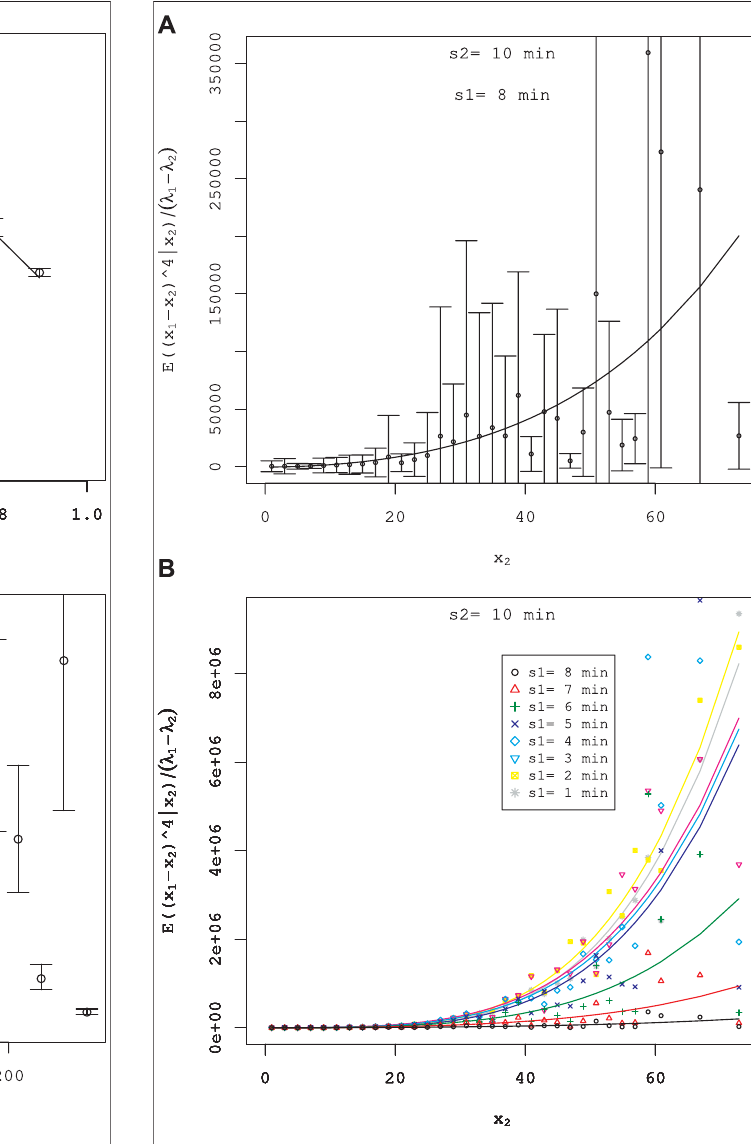
(cid:7) (cid:7) (cid:7)(cid:7) x (cid:2) x ) / ( λ − λ ) by a quartic 2 1 2